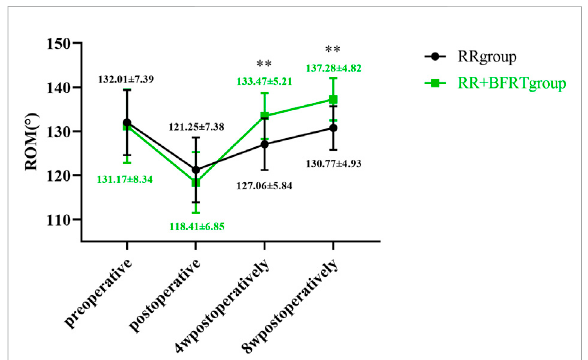
FIGURE 17 Comparison of knee ROM between RR group and RR + BFRT group at different time points ( ° ). “ ** ” indicates a signi fi cant change ( p < 0.01). Values are presented as mean ± SD. RR Group: routine rehabilitation group; RR + BFRT Group: routine rehabilitation + blood fl ow restriction training